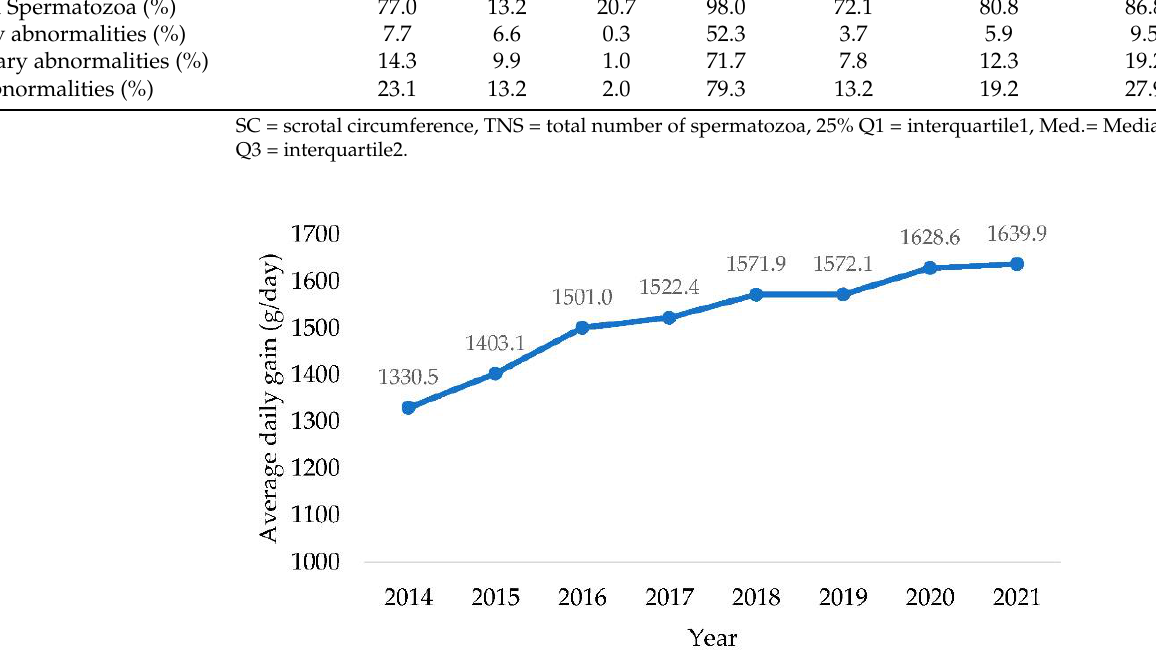
Figure 1. The trend of the average daily gains of 577 Italian Simmental young bulls recorded during performance test in the time interval comprised from 2014 to 2021.